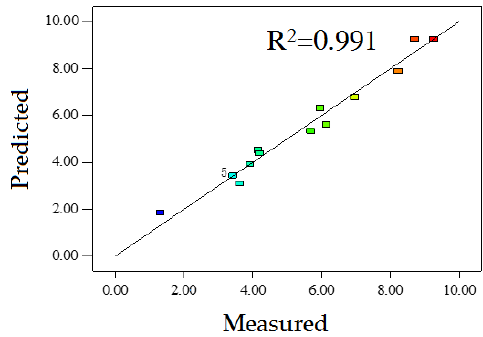
Figure 5. The measured and predicted values of the air voids.